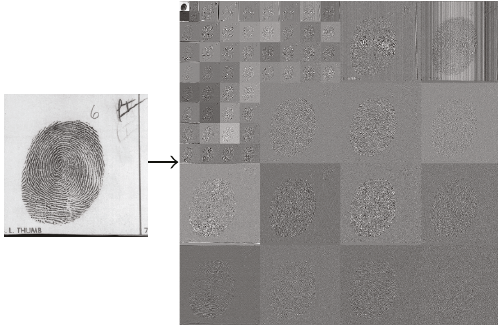
Figure 3: Visualization of SWT